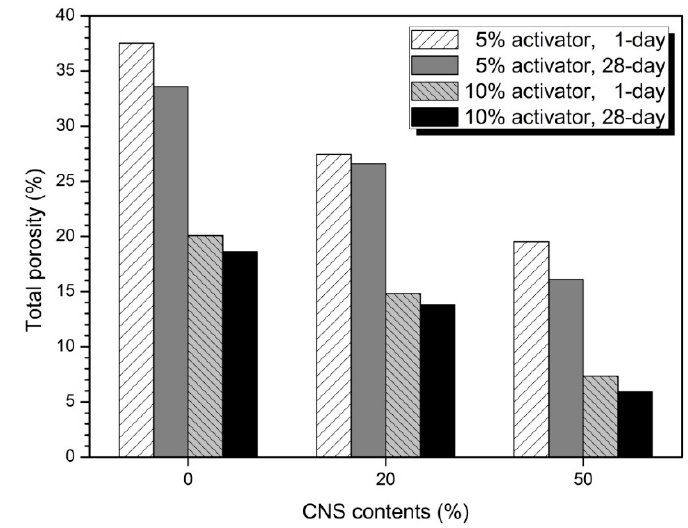
14 of 23 Figure 6. MIP analysis: ( a ) 5% activator, 1-day, ( b ) 5% activator, 28-day, ( c ) 10% activator, 1-day, ( d ) 10% activator, 28-day. Figure 7 shows the total porosity of 0, 20, and 50% CNS. As the substitution rate of CNS